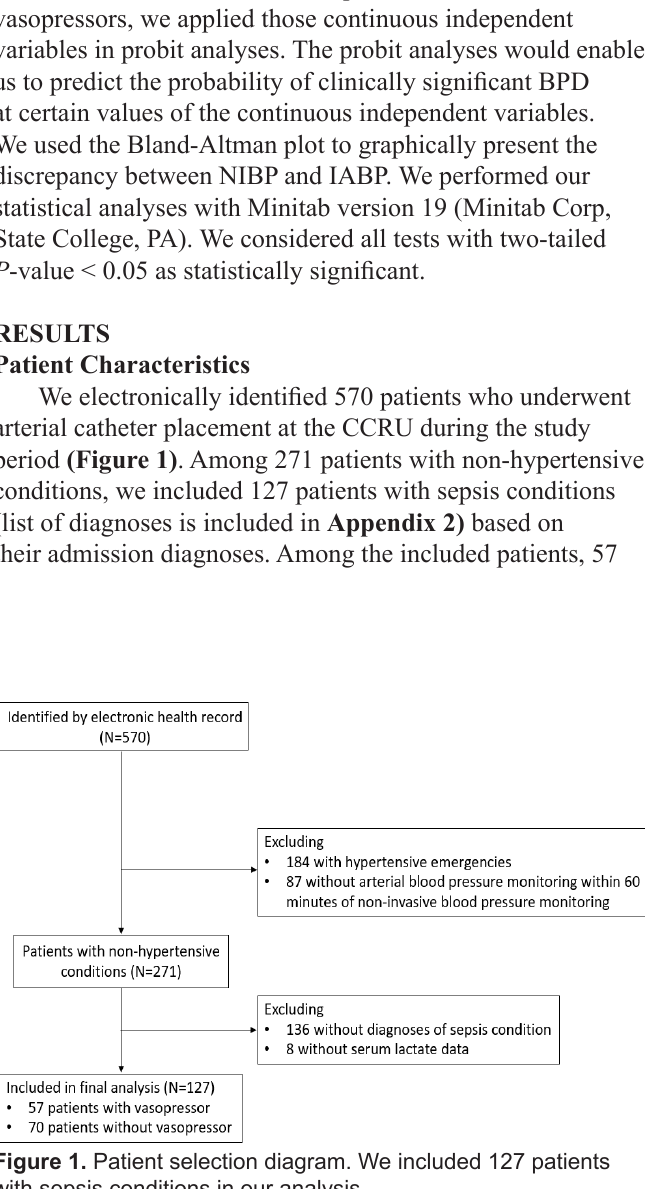
(45%) required vasopressors and 70 (55%) did not require vasopressors (Table